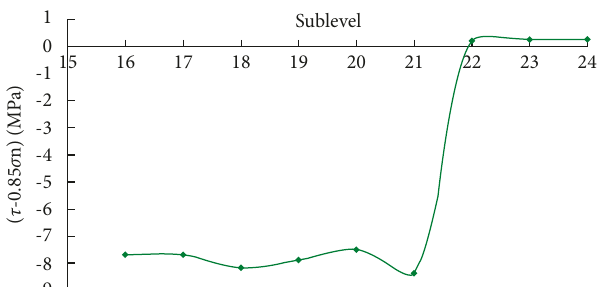
Figure 17: The sliding property of fault FC2 varies with mining depth.